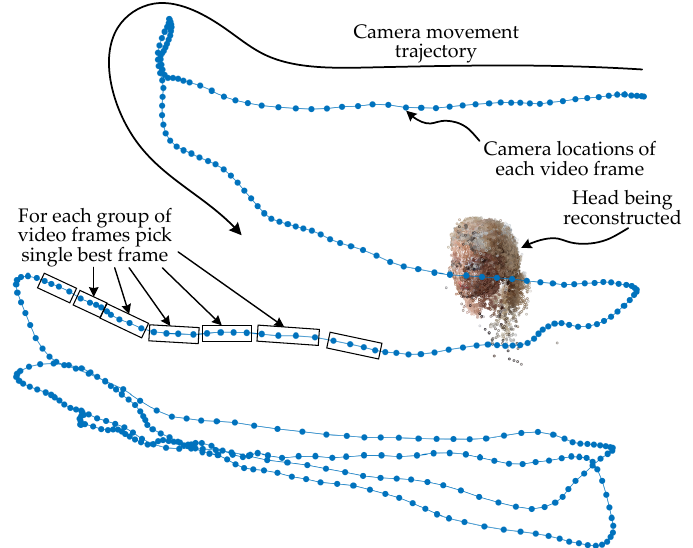
Figure 1. The need for finding the least motion-blurred (highest quality) image from several images during 3D head reconstruction using a photogrammetry approach. Such a selection process reduces data redundancy and removes distorted images; therefore, the reconstruction process becomes faster and the resulting model is more accurate. In self-recorded videos using smartphones, motion blur is the most affecting image quality factor that can be managed after a video is recorded. So the problem of choosing the highest quality image becomes a motion blur evaluation